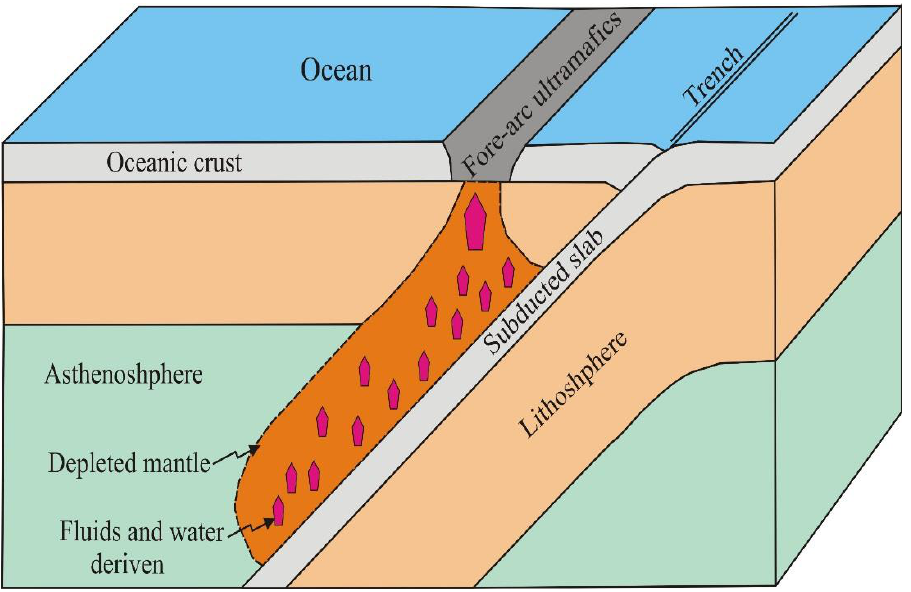
Figure 11. Schematic illustration showing the tectonic setting of the examined ultramafic rocks, modified from [79].